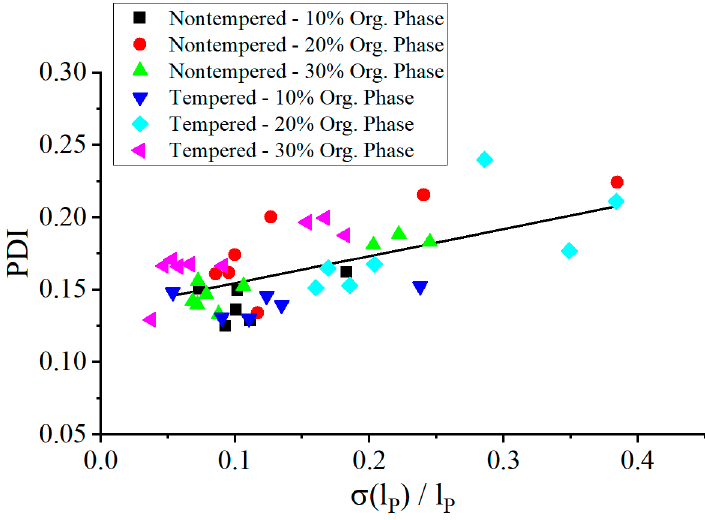
Figure 10. The polydispersity index (PDI) dependent on the standard deviation of the plug length normalized by the average plug length. The trend line was calculated from all measuring points and only serves as a guide for the eye.